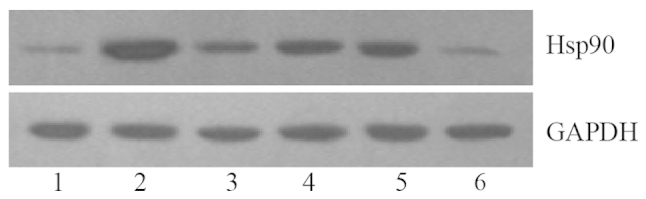
Western blot analysis results of Hsp90 protein expression bands induced by VEGF-C in the presence or absence of various inhibitors in HeLa cells. Lane 1: Control; Lane 2: VEGF-C + KDR-Ab; Lane 3: VEGF-C + PD98059; Lane 4: VEGF-C + LY294002; Lane 5: VEGF-C + GA. Hsp90, heat shock protein 90; GA, geldanamycin; VEGF-C, vascular endothelial growth factor-C.